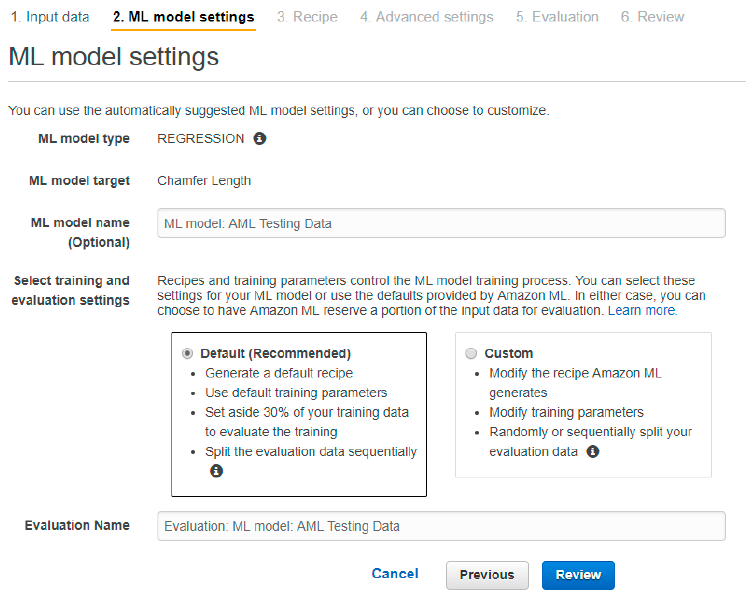
Figure 9. The AML model recipe selection.